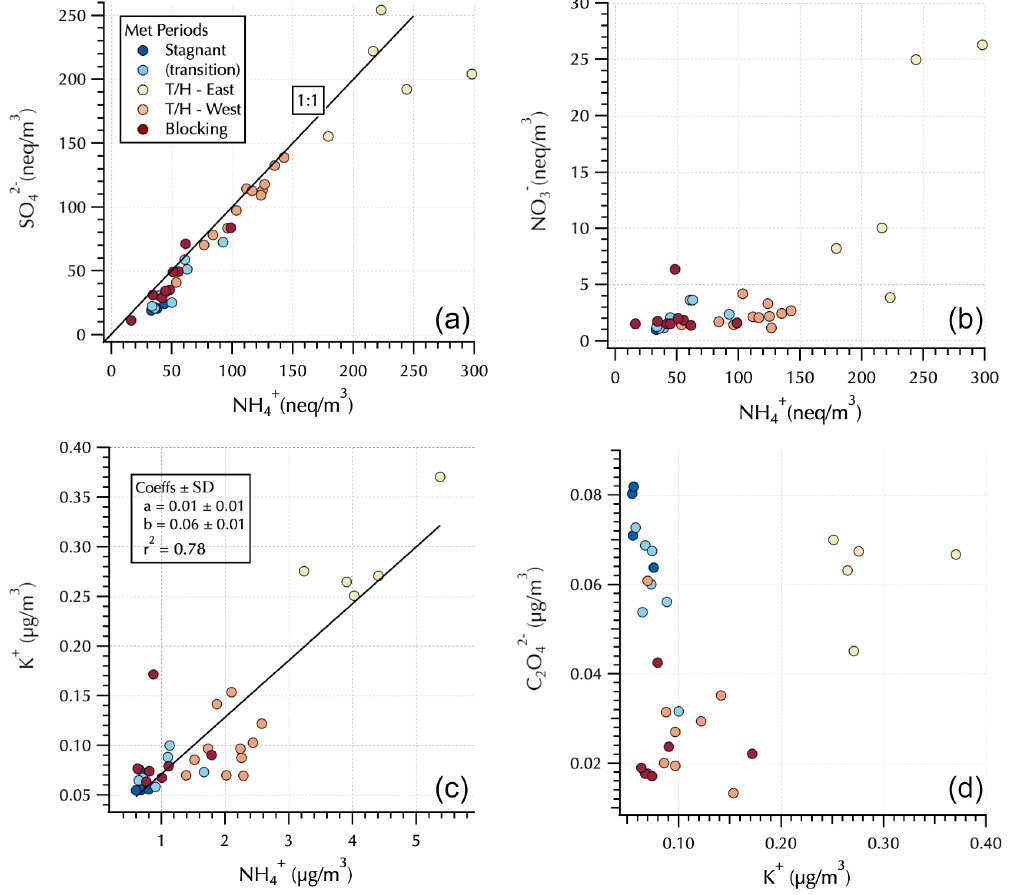
Figure 4. Relationships between SO 2 − and K + (d) in mass units. Markers are colored by Peterson et al. (2019) meteorological regime with the Transport/Haze – East samples downwind of South Korea and the Transport/Haze – West samples upwind of South Korea (see Fig. 1) under the prevailing low-level westerly transport from China during this meteorological